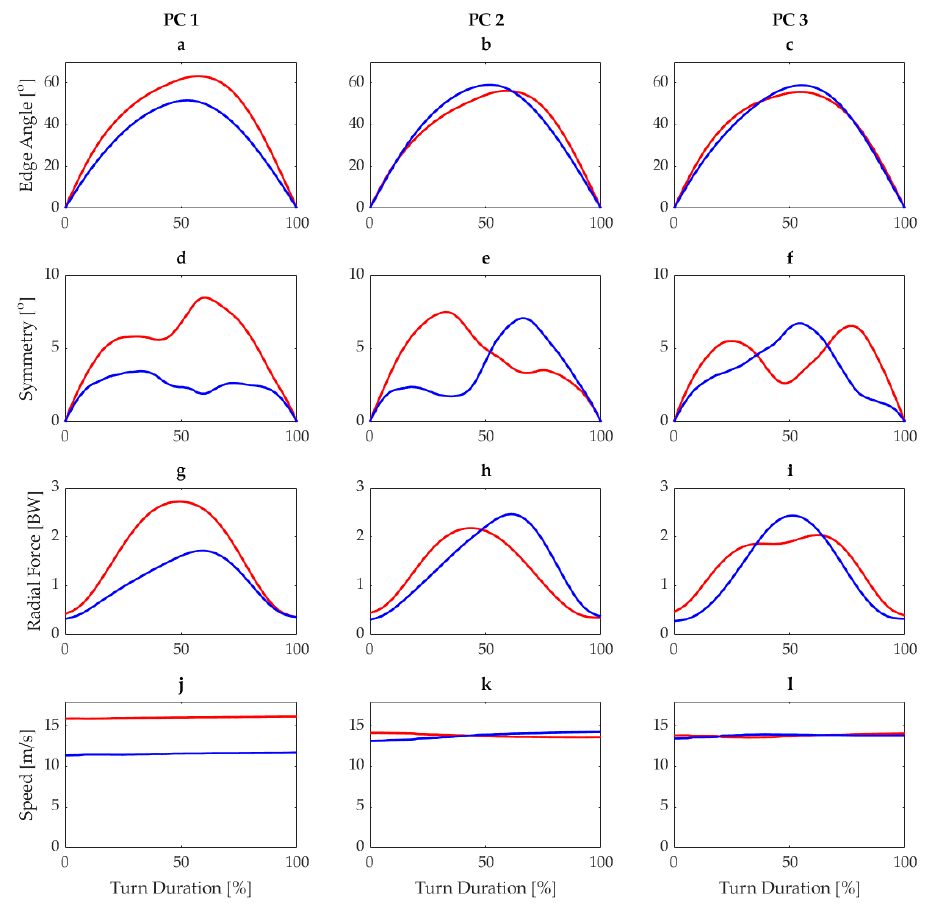
Figure 3. Responses for first three principal components for edge angle ( a – c ), edge angle symmetry ( d – f ), radial force ( g – i ), and speed ( j – l ) for carving short from the reference dataset. Blue lines represent the mean load score − 1SD and red lines represent mean load score +1SD.